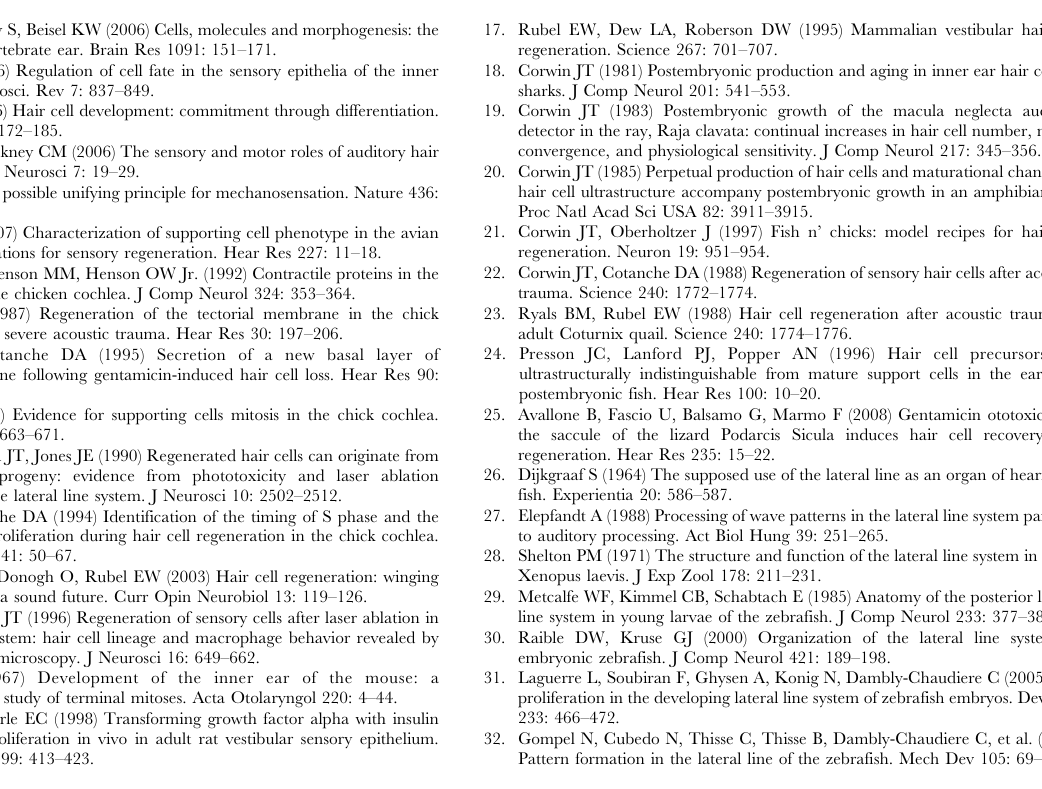
AP/DV ventral orientation is indicated. C. Immunofluorescence on cultured zebrafish cells (Pac2) using EX1 (green in the top and bottom left panels) or EX7 (green in the top and bottom right panels) antibodies. To highlight the ER, we co-stained with an antibody against PDI (ER-associated protein disulfide isomerase, red in middle and bottom left and right panels). DAPI was used to counterstain nuclei (blue in the two bottom left and right panels). Merged images (bottom, left and right panels) showed a cytoplasmic staining of phoenix, which was more concentrated in the perinuclear region. It appeared excluded from the ER, as there was no co-localization with DPI. Note how phoenix protein was upregulated in cells preparing to enter division (white arrow in the top right panel). D. Western blot on PAC2 cell extracts with two rabbit polyclonal antibodies, raised against an